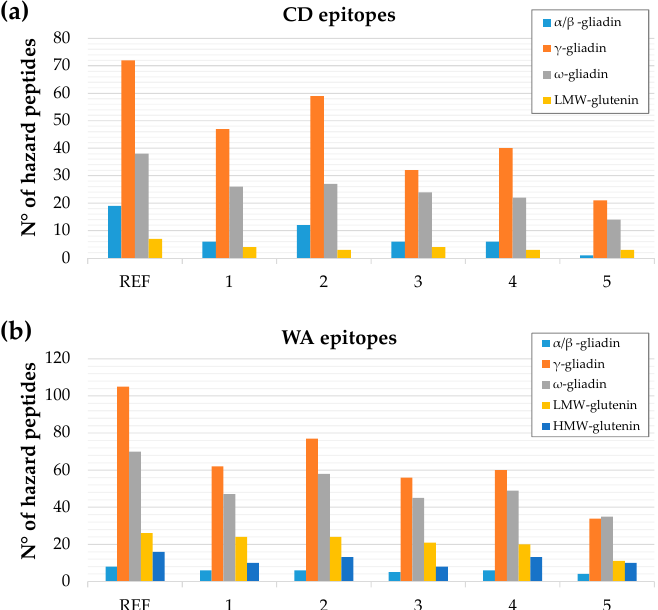
Figure 5. Distribution among the main proteins of the hazard peptides detected in GD digest containing intact epitopes relevant for CD ( a ) and WA ( b ).